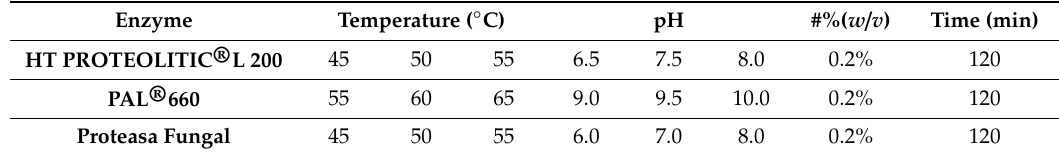
Table 2. Conditions for each of the enzymes.